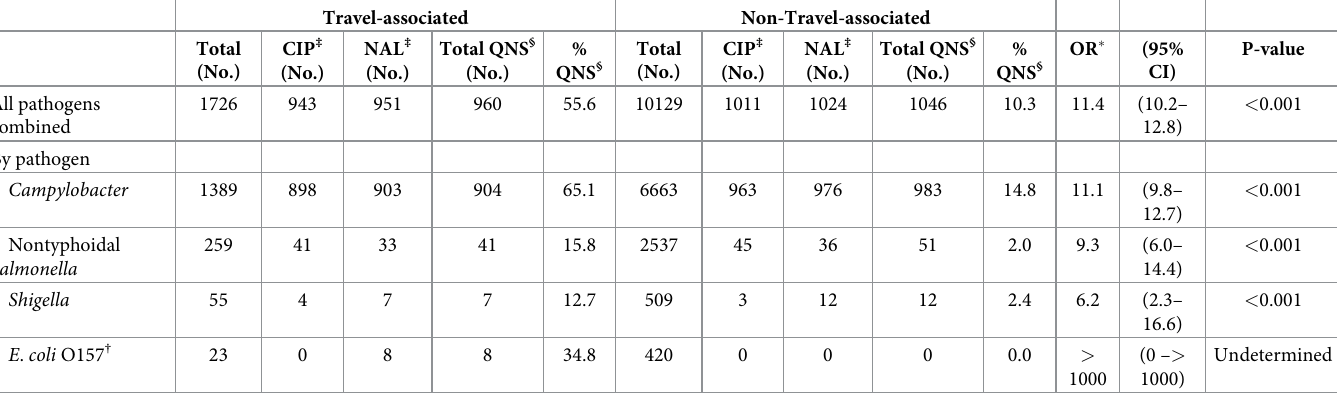
Table 1. Distribution and adjusted odds ratios of quinolone-nonsusceptible infections for international travelers compared with non-travelers, by pathogen, Food- borne Diseases Active Surveillance Network and National Antimicrobial Resistance Monitoring System, United States,